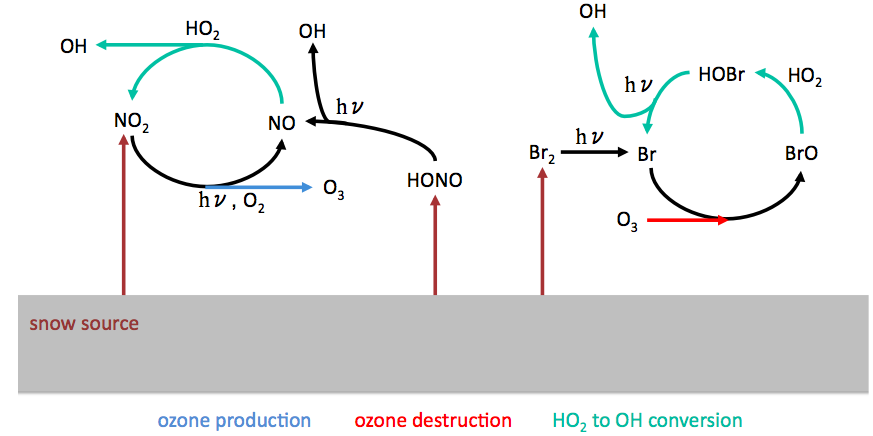
Fig. 1. Schematic of snow sourced NO x , HONO, and bromine and their impact on ozone production and destruction. The figure also captures the impact of snow emissions on OH. Both NO x and bromine cycling shift the OH:HO 2 ratio towards OH. Snow sourced HONO is a direct source of